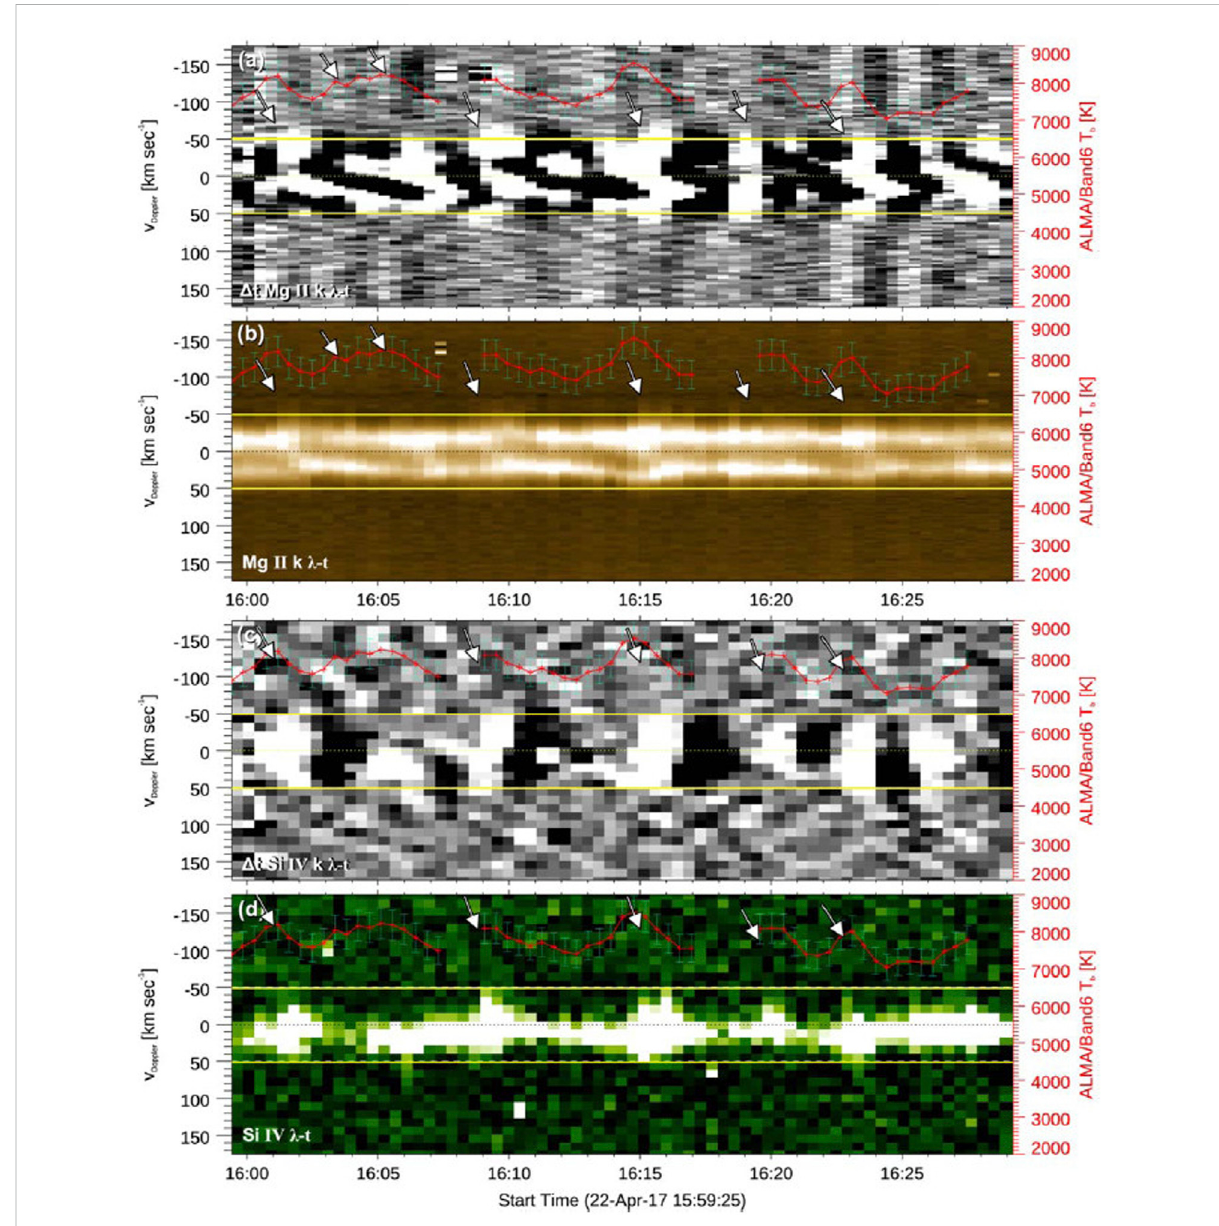
FIGURE 15 Wavelegth-timeplotfor Mg II k (panel B )and itstemporalderivative (panel A )ofa 1 ″ × 1 ″ area above aplage with recurrent shock waves. Panels (C , D) same as panels (A , B) but for Si IV. In all panels the 1.25 mm emission is overplotted (red curves). The rest-wavelegth position is marked with a dotted line. The arrows point to blueshifts and correlated 1.25-mm emission increases (from Chintzoglou et al., 2021b). © AAS. Reproduced with